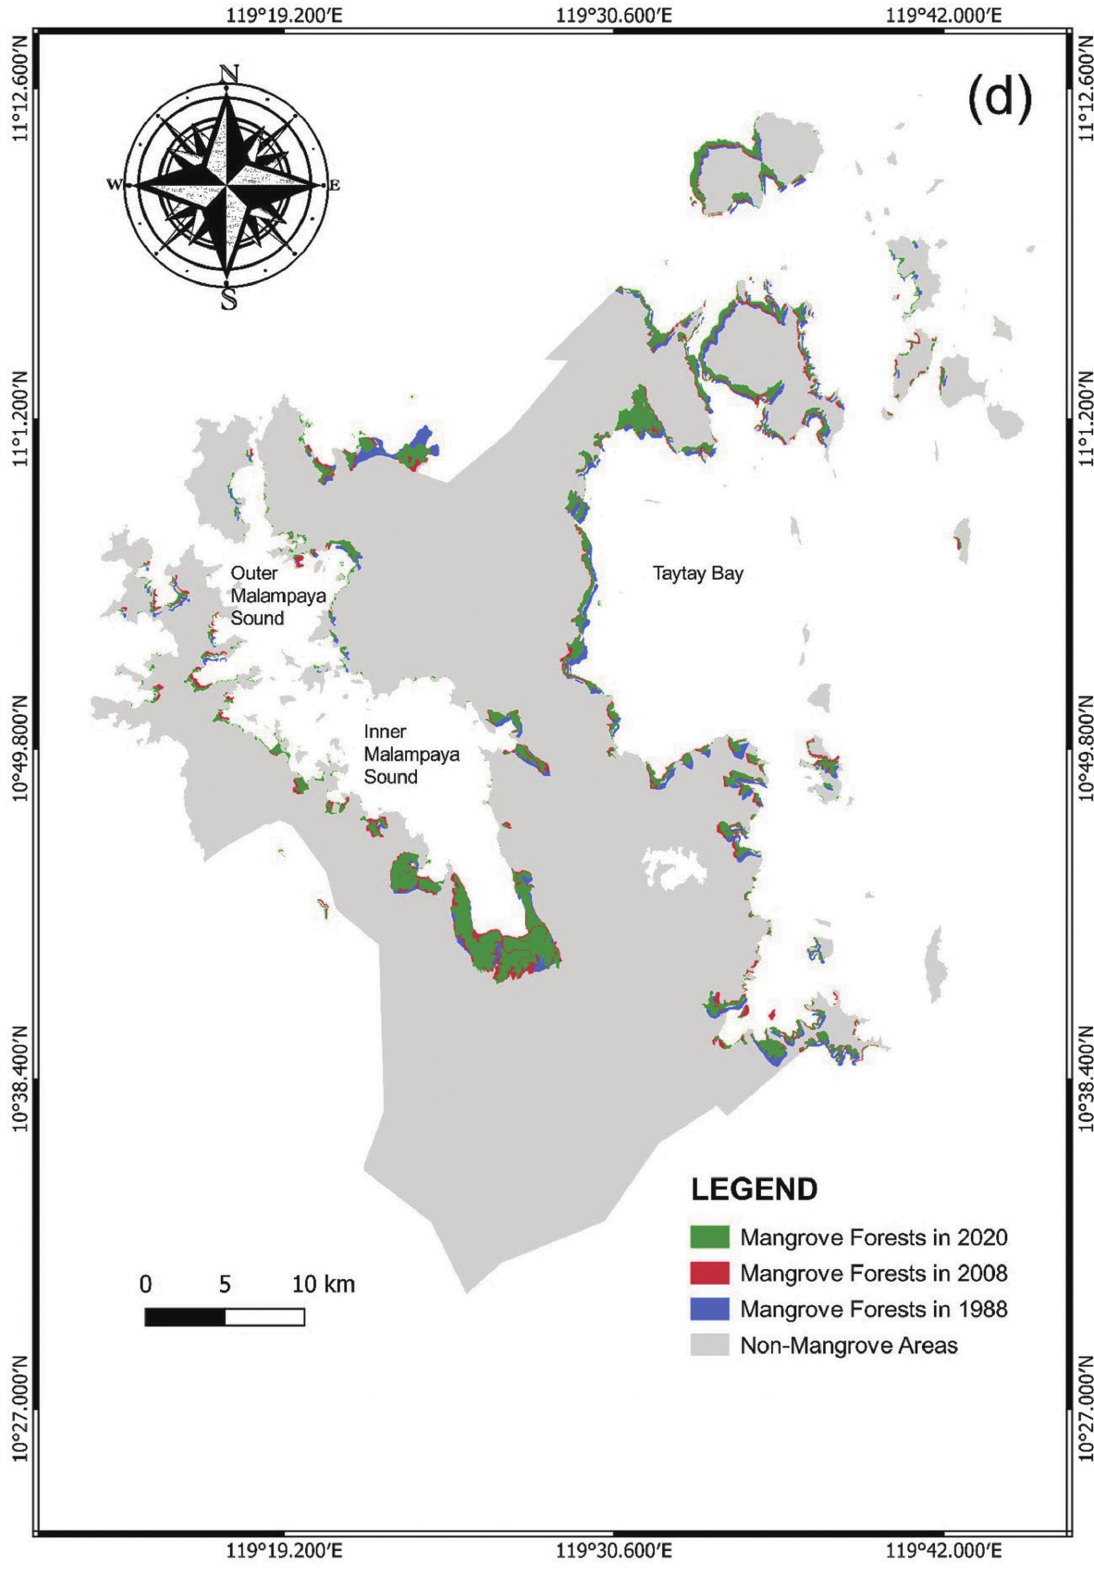
Multi-spatiotemporal analysis of changes in mangrove forests in Palawan,